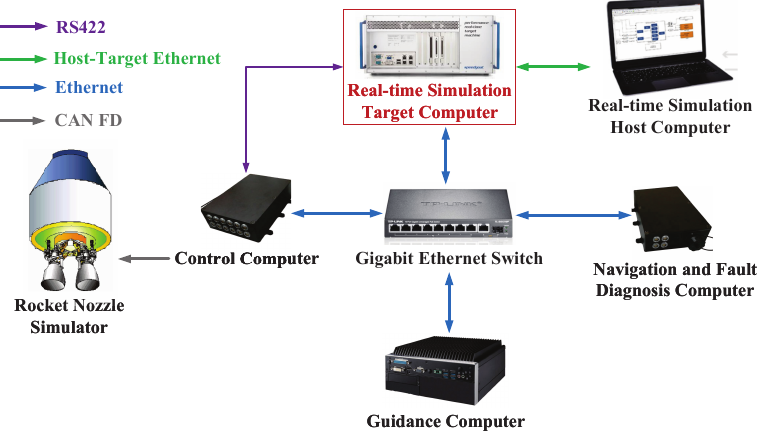
Figure 3. Hardware-in-the-loop simulation system framework.